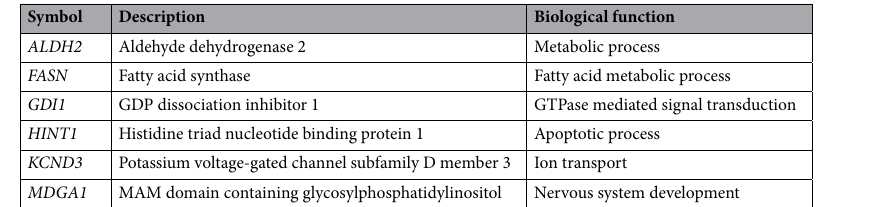
Table 2. Predicted miR-486-3p target genes identified by